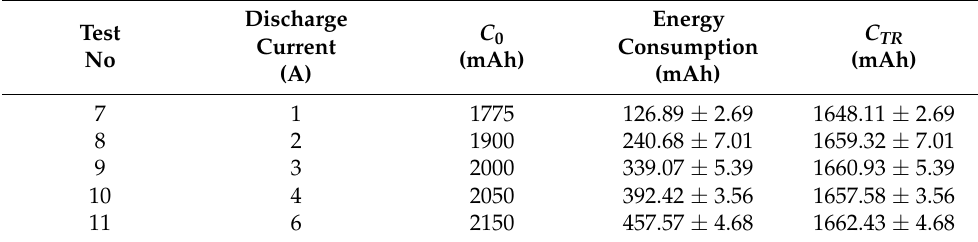
Table 5. Capacity variation during the thermal runaway process in Group iii.